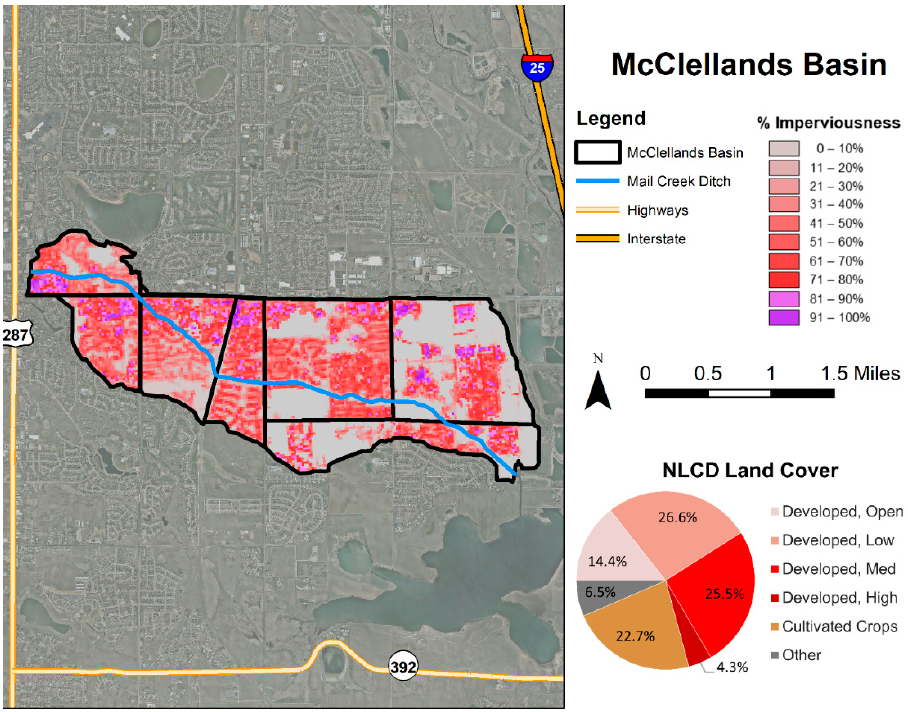
Figure 1. Location of the McClelland basin.